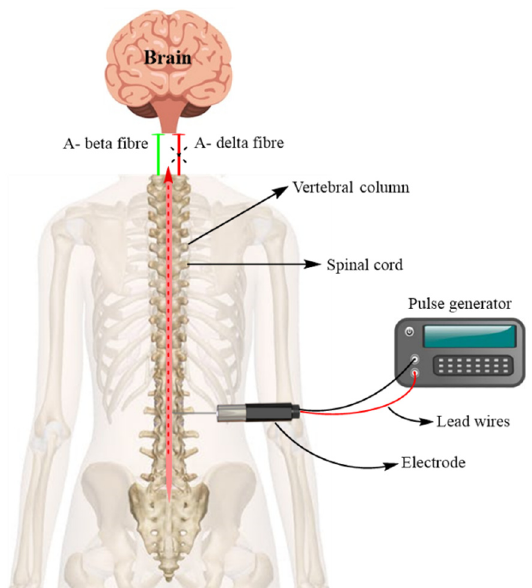
Figure 4. Spinal cord stimulation therapy for neuropathic pain. A pulse generator sends a low- threshold electric current through an extension wire to an electrode placed in the epidural space. Generated non-nociceptive signals (A β fibers) mask the travel of nociceptive signals (A δ and C-fibers) to the brain, thus causing pain relief.